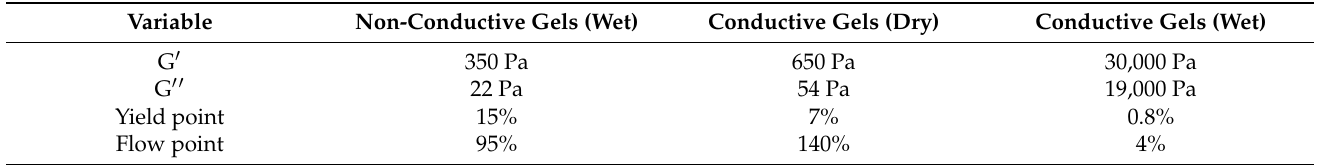
Table 2. Rheological properties of the non-conductive and conductive